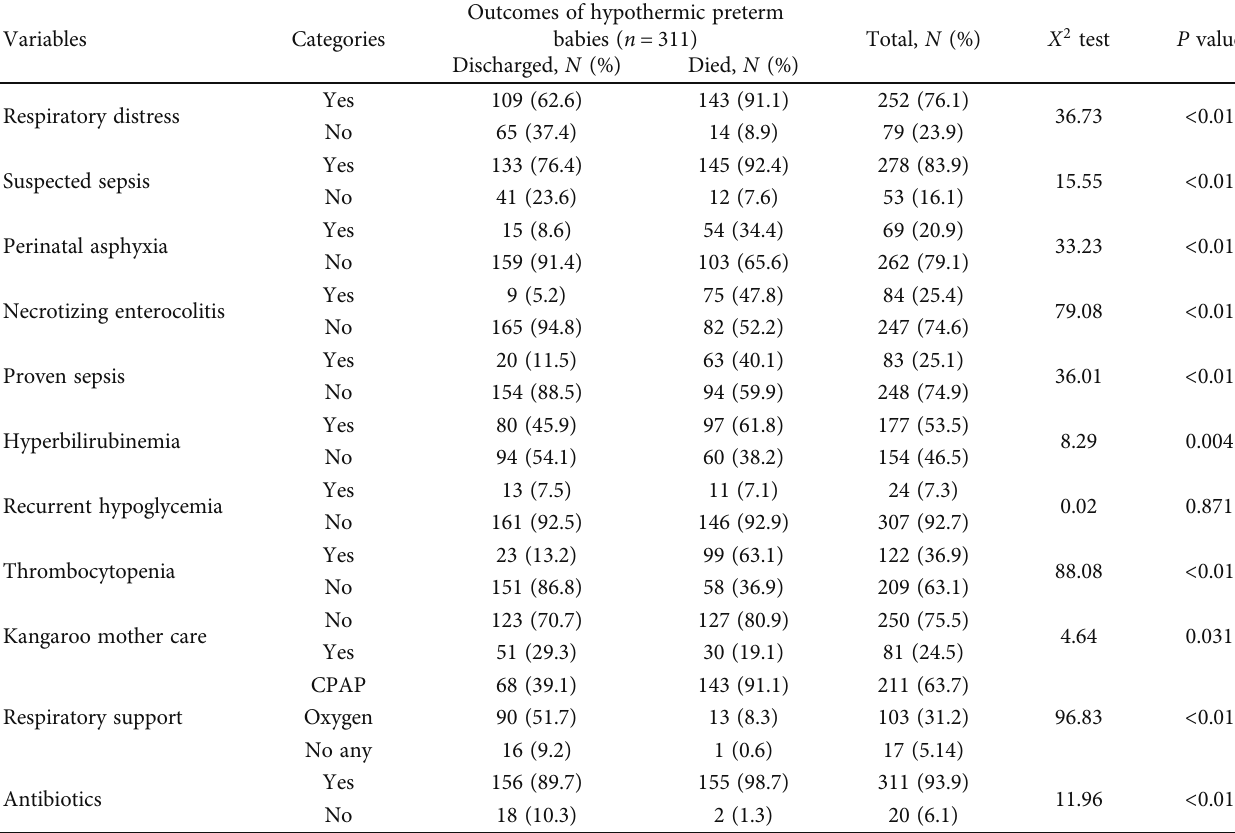
Table 2: Cross-tabulation showing the clinical and treatment characteristics of babies with outcomes of hypothermic preterm babies in Addis Ababa public hospitals, 2022.